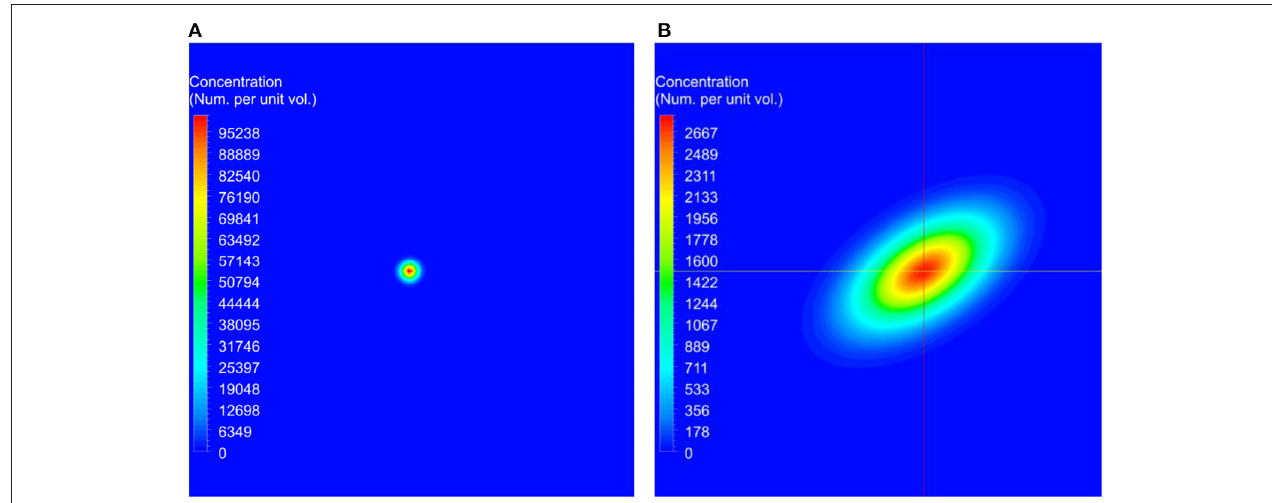
FIGURE 2 | The initial conditions used for the benchmark simulations and the predicted concentration at the end of the simulation. In these figures, red represents higher concentrations and blue represents lower concentrations. (A) Initial concentration used at the beginning of the simulation. (B) Computed concentration after